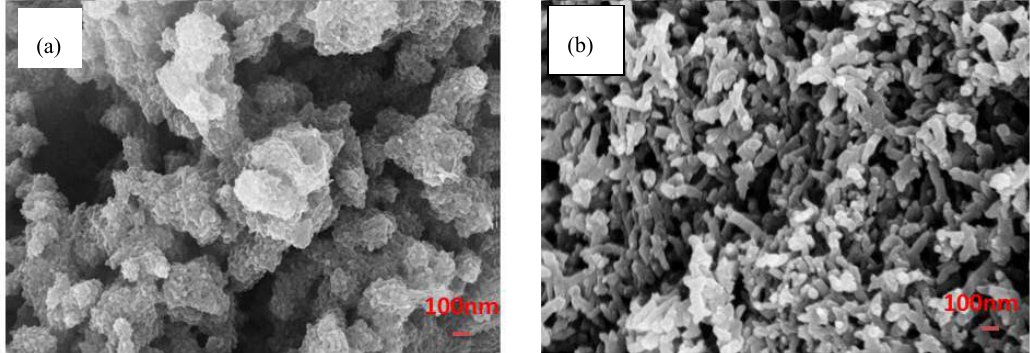
Figure 2. Field Emission Scanning Electron Microscopy (FESEM) image of ( a ) granular PANI synthesized by conventional method; ( b ) PANI nanofiber synthesized by interfacial